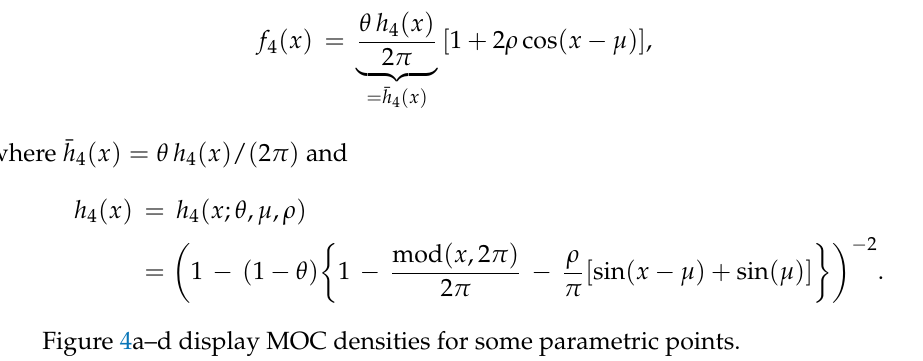
Figure 4a–d display MOC densities for some parametric points.